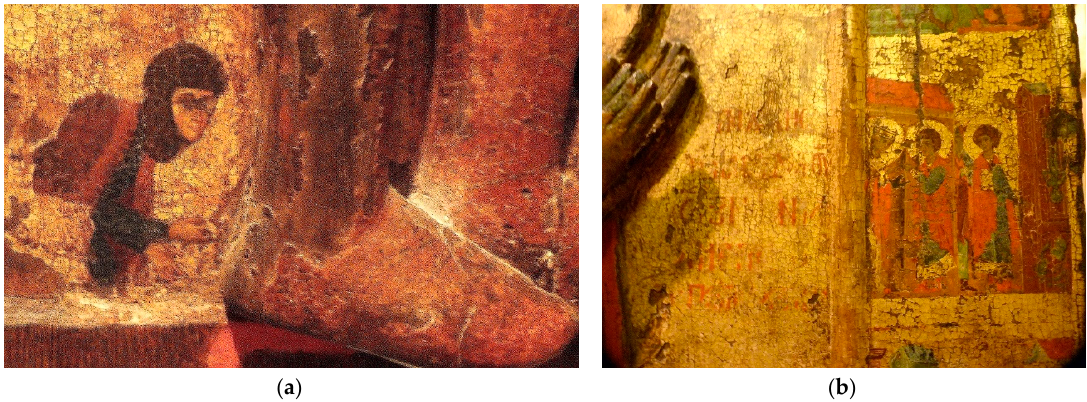
Figure 12. Bilateral wooden-relief Vita icon of St George, Kastoria, second half of the 13th century. Byzantine and Christian Museum, Athens, BXM 1108. ( a ) Kneeling widow at the feet of St George. ( b ) Conversion of Alexandra. © Author.